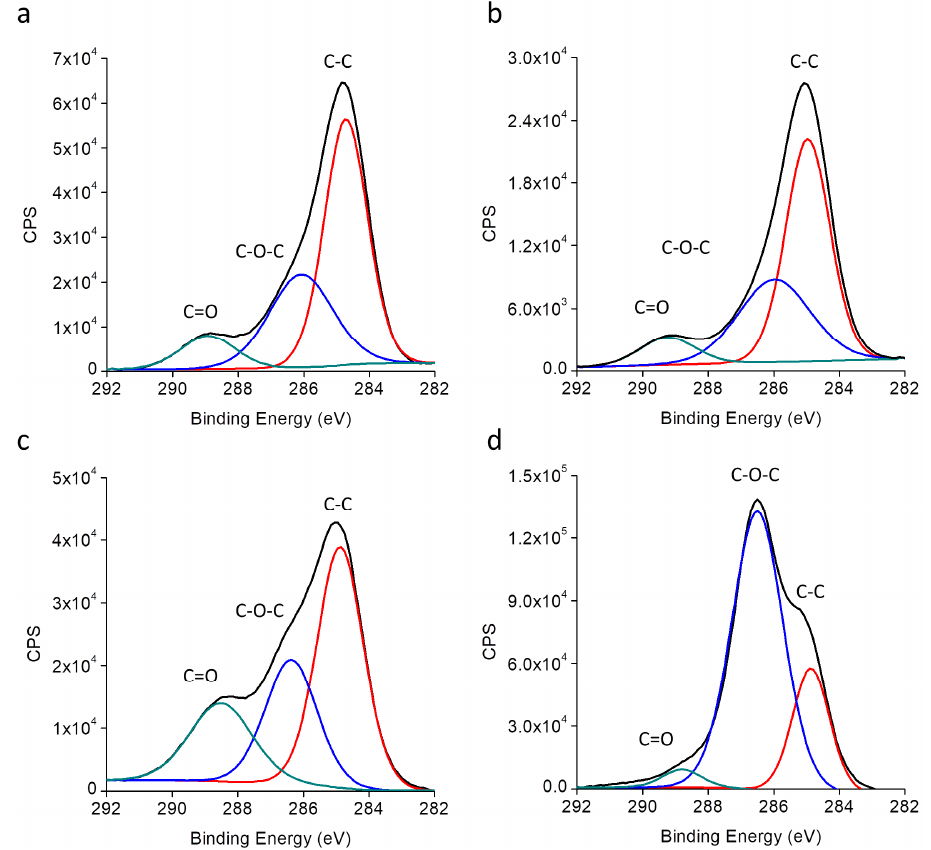
Figure 3. High resolution XPS spectra of the C 1 s signal with the peak decomposition, corresponding to Ti ( a ), Ti_PA ( b ), Ti_PEG_cont ( c ), and Ti_PEG_5_4 ( d ).